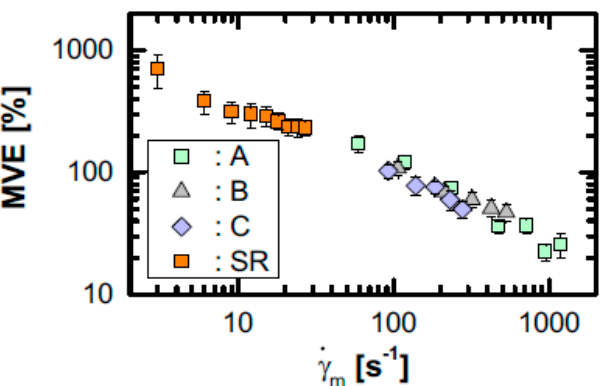
Figure 22. Comparison of MVE data obtained with the capillary viscometer (for three capillaries A, B, C) and with cone-plate setup by rotational rheometry (SR) at the magnetic field strength H = 30 kA / m. Reprinted with permission from Reference [167].